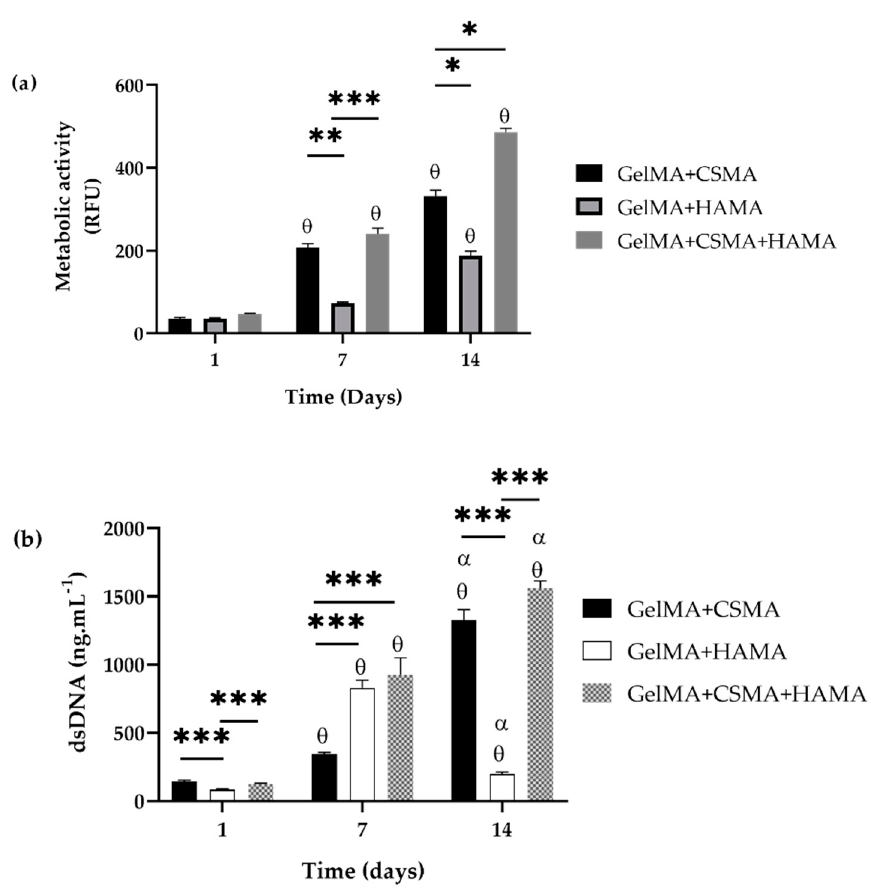
Figure 9. In vitro assessment of the biological performance of di ff erent GelMA–based hydrogels seeded with ATDC5 over cell culture time, with the correspondent statistical analysis (* p < 0.05, ** p < 0.01, *** p < 0.001, and symbols denote statistical di ff erences when compared each of the conditions at each time point and compared with day 1 ( θ ) and day 7 ( α ). Data are presented as mean ± SD (n = 3). ( a ) ATDC5 metabolic activity; ( b ) ATDC5 proliferation assessed by quanti fi cation of dsDNA.